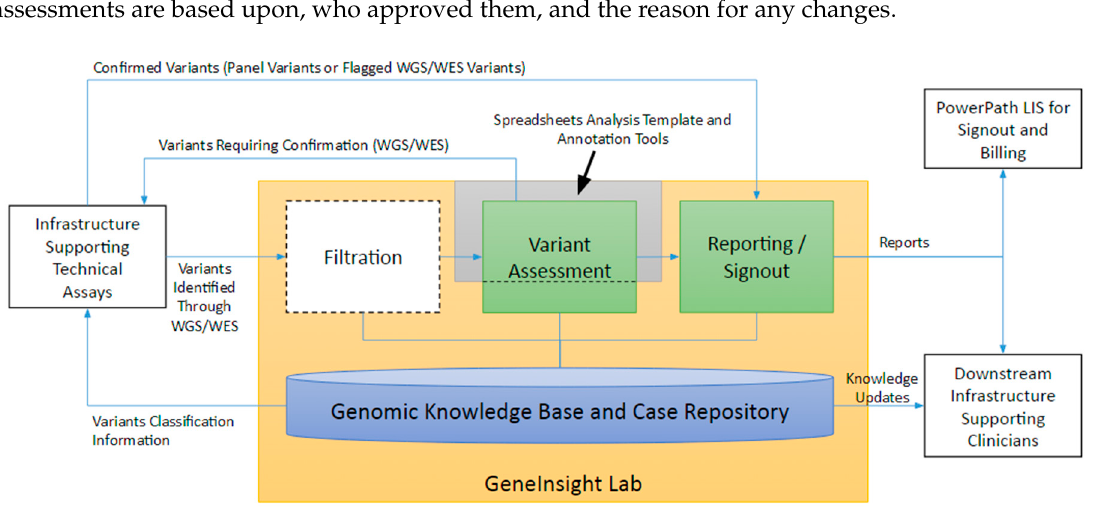
Figure 4. Infrastructure Supporting Interpretation.